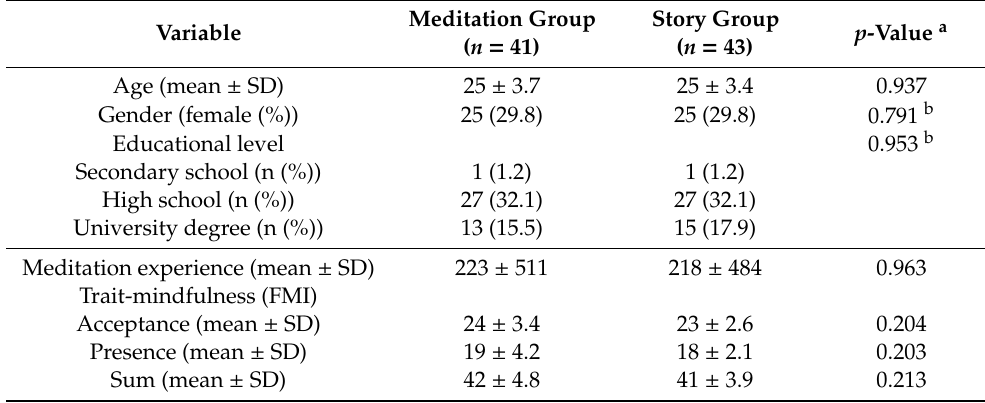
Table 1. Descriptive statistics of the two study groups ( n = 84).